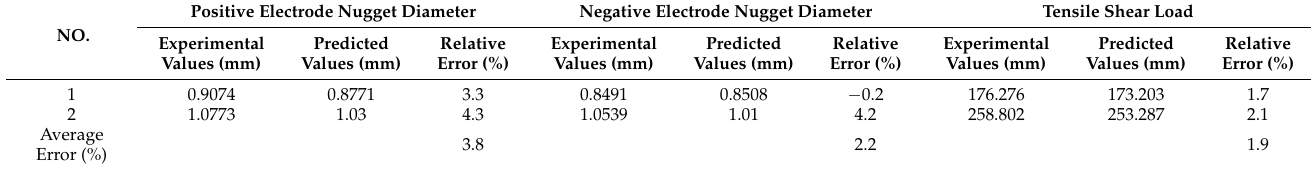
Table 8. Method I verification of relative error.